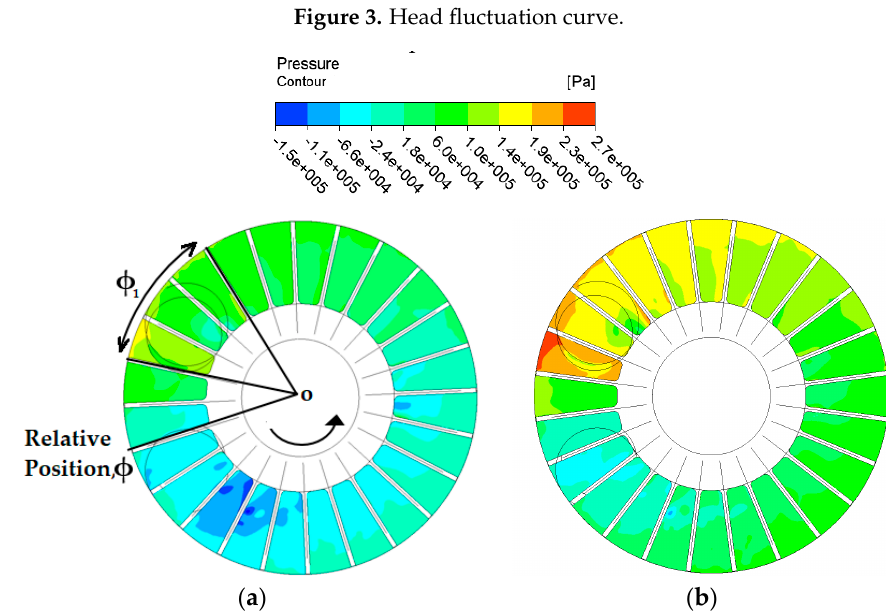
Figure 3. Head fluctuation curve.